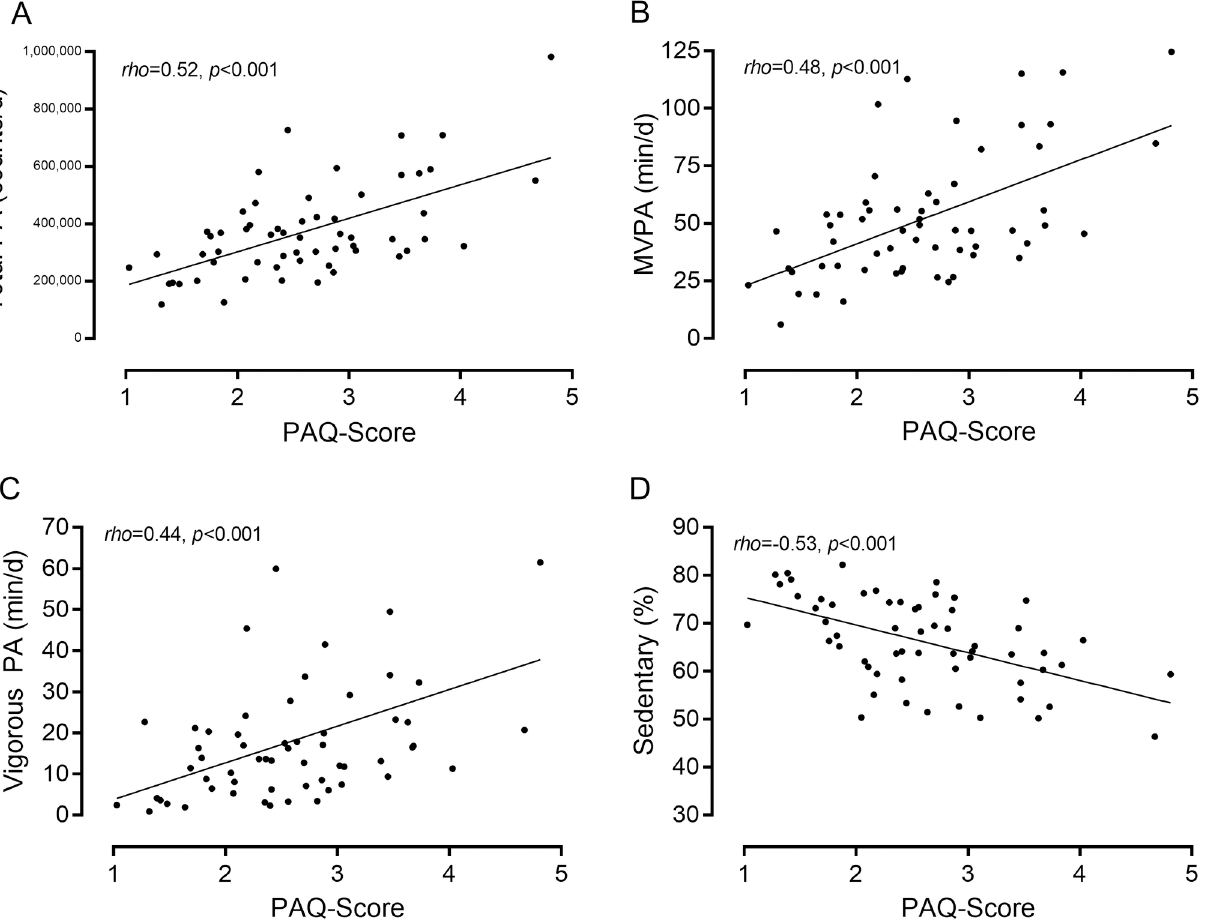
Fig 1. Association between PAQ-Score and various accelerometry-derived physical activity metrics.